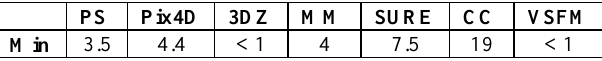
Table1. Millions of points of the generated clouds.